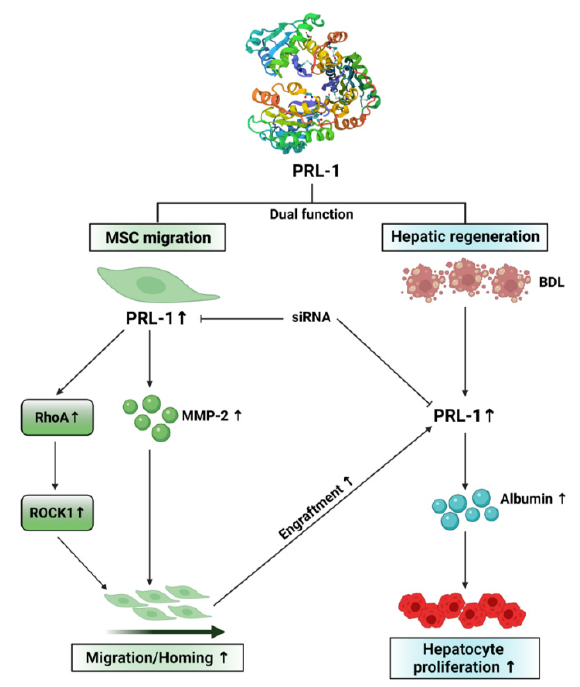
Figure 7. A proposed model of CP ‐ MSC ‐ induced hepatic regeneration through regulation of PRL ‐ 1 expression. Migration of transplanted CP ‐ MSCs to the damaged liver tissues was regulated by a PRL ‐ 1 ‐ mediated Rho family signaling pathway. Engrafted CP ‐ MSCs stimulated hepatic regenera ‐ tion in damaged liver tissues through increased PRL ‐ 1 expression and enhanced hepatic prolifera ‐